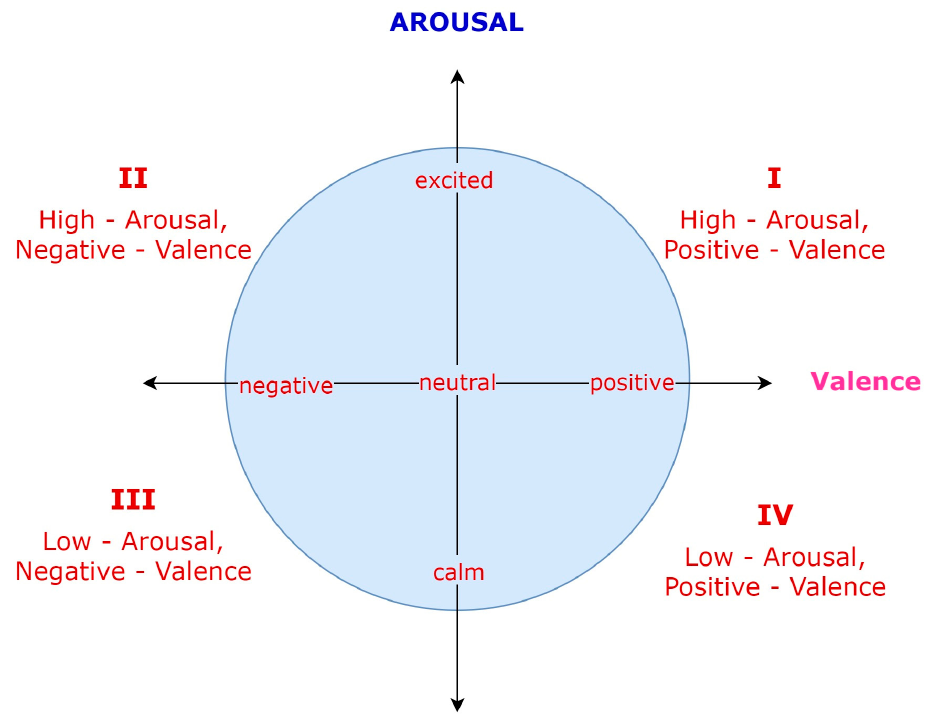
Figure 1. Two-dimensional valence–arousal representation, based on [37].